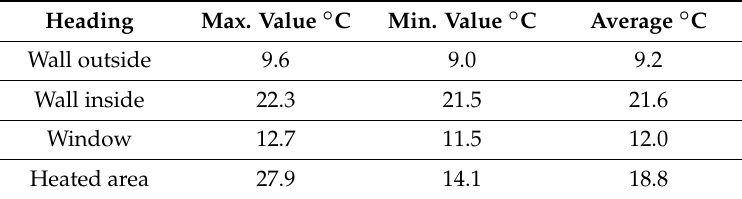
Table 5. Characteristic temperature values of the outer envelope.